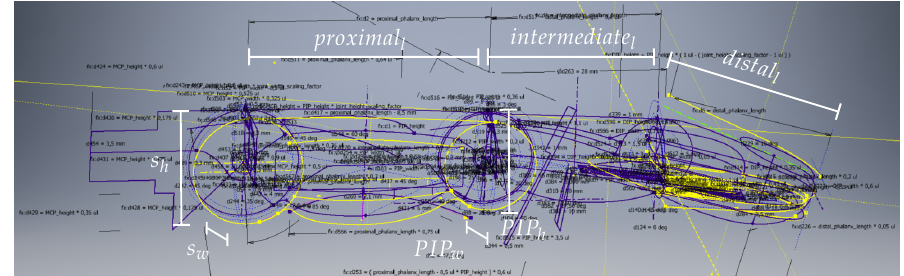
Figure 2. Skeleton sketches used for the individual phalanges. The seven high-level parameters are used in these sketches to derive all dependent dimensions of the